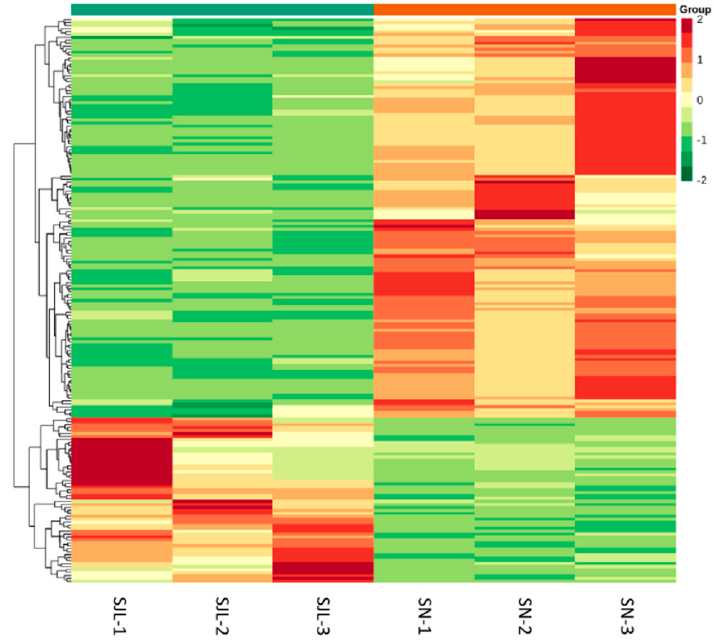
Figure 5. A heatmap for the relative variation of metabolites between SJL and SN. The color-coding from red to green indicates abundances from high to low, respectively.